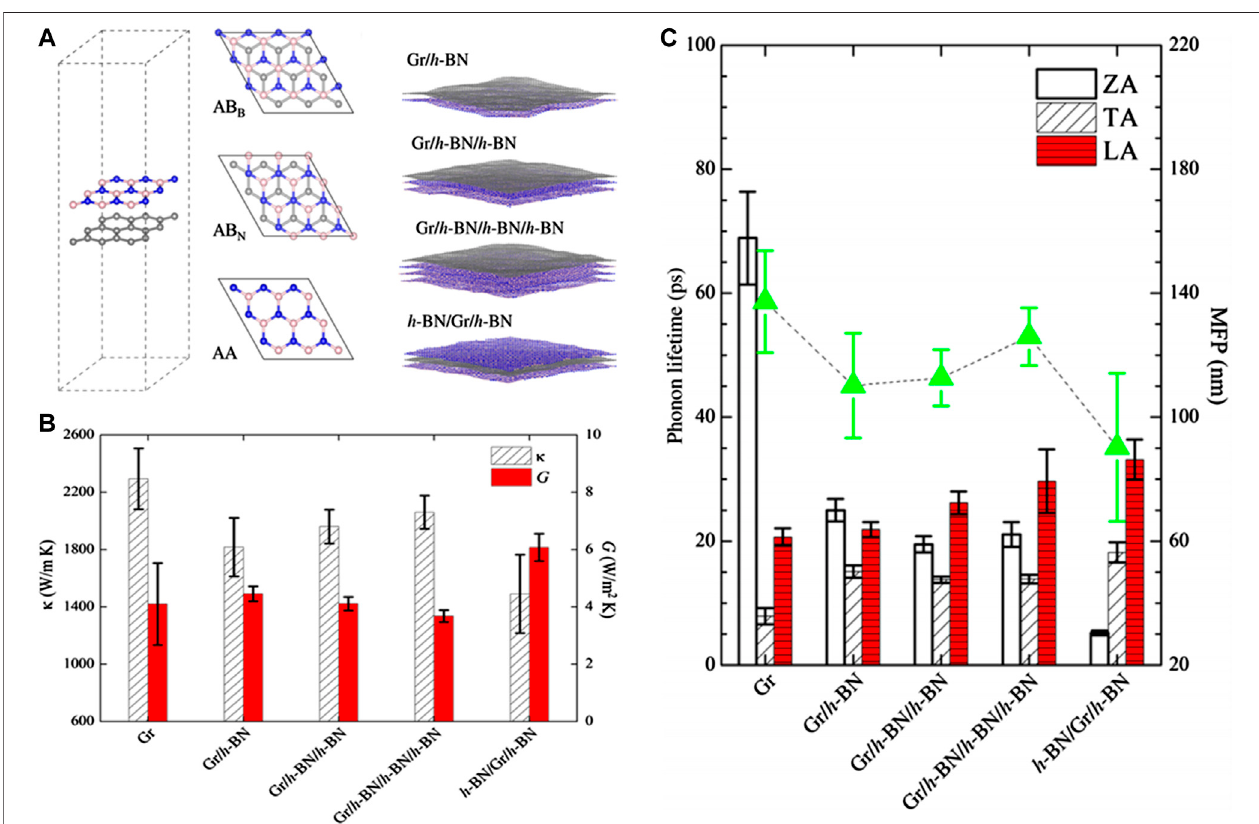
FIGURE 5 | (A) Schematic of the graphene and h-BN heterostructures used in MD simulations, Gray, pink, and blue balls represent C, B, and N atoms, respectively. (B) Thermal conductivity ( κ ) and thermal conductance ( G ) of the listed systems at 300 K. (C) Comparison between the listed graphene/h-BN heterostructuresofthephononlifetimesforthethreeacousticmodesataKpointneartheBrillouin-zonecenterextractedfromSEDanalysisandeffectivemeanfreepath (MFP) of phonons. Reproduced from with permission from (Pak and Hwang, 2016) American Physical Society.